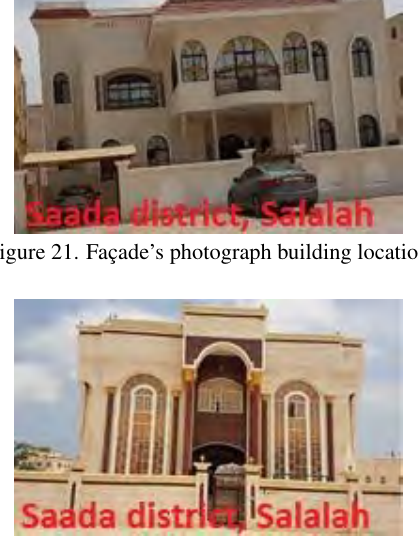
Figure 22. Fac¸ade’s photograph building location